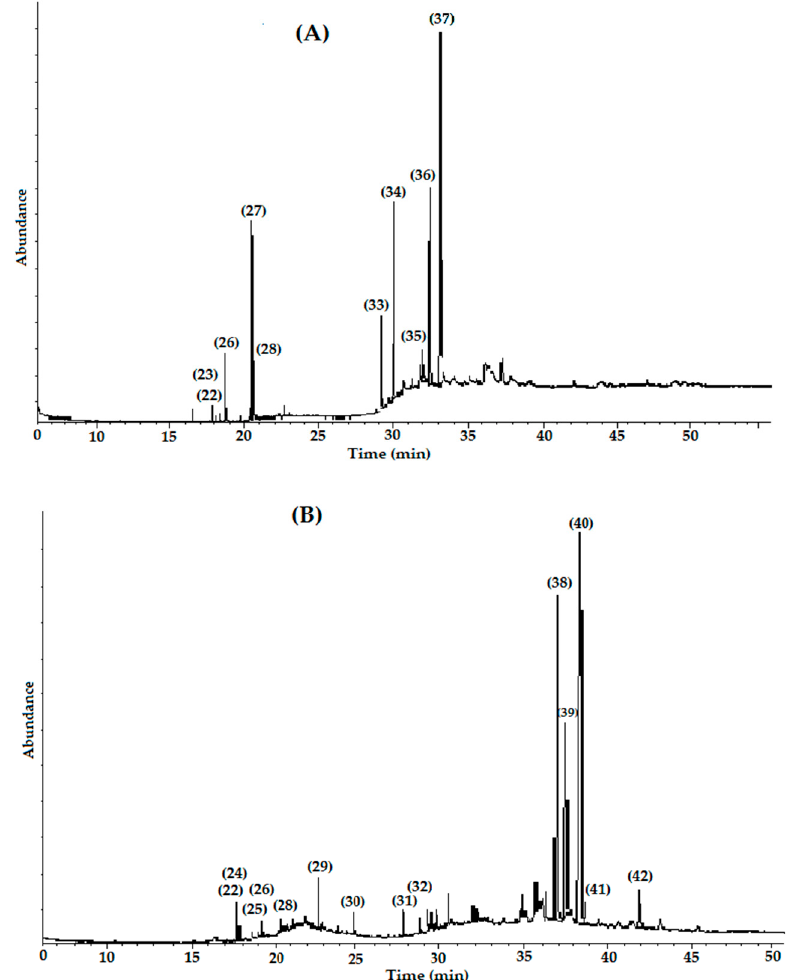
Figure 2. GC chromatograms of the hexanic extracts: ( A ) Ij-BH and ( B ) Ij-LH . The peaks are numbered in ascending order according to their retention times. Table 3. Phytochemicals identified in hexanic extracts from the bark ( Ij-BH ) and leaves ( Ij-LH ) of Inga jinicuil by GC-MS.